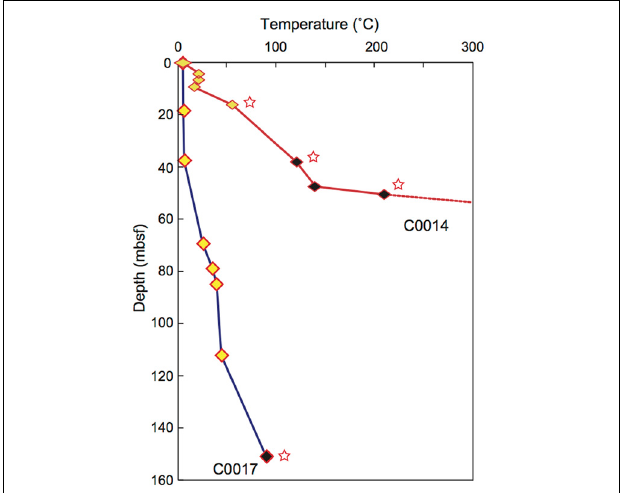
FIGURE 1 | Depth profile of temperature at Sites C0014 (red) and C0017 (blue), as measured by the by APCT-3 temperature shoe and thermoseal strip taped to the outer surface of the core liner. Yellow, APCT-3; black, thermoseal strip. Stars; minimum values. Modified from Takai et al.